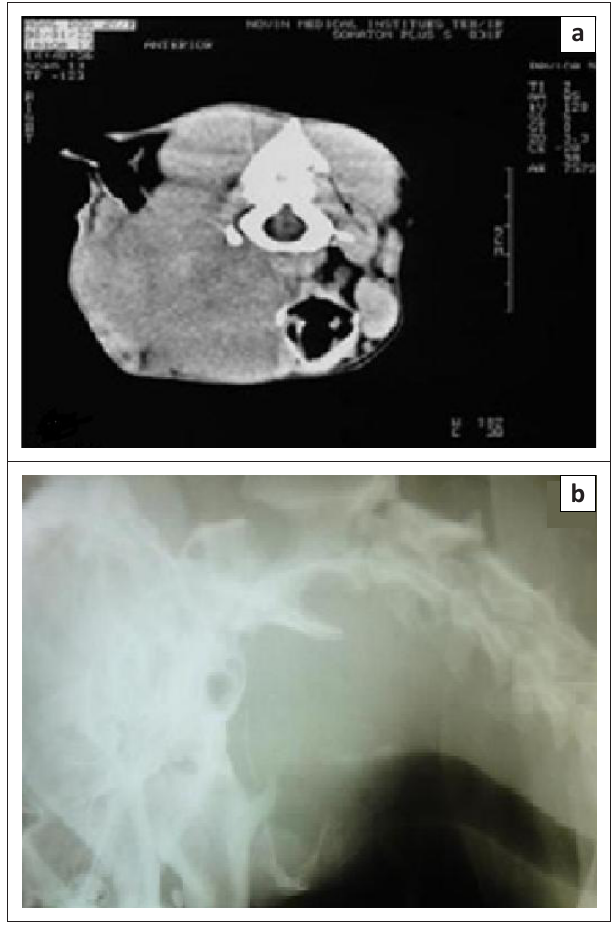
FIGURE 2: (a) Transverse computed tomography scan, showing the large amorphous mass on the left side of the dog’s neck, (b) lateral radiography of the cervical part with soft tissue swelling and displaced hyoid